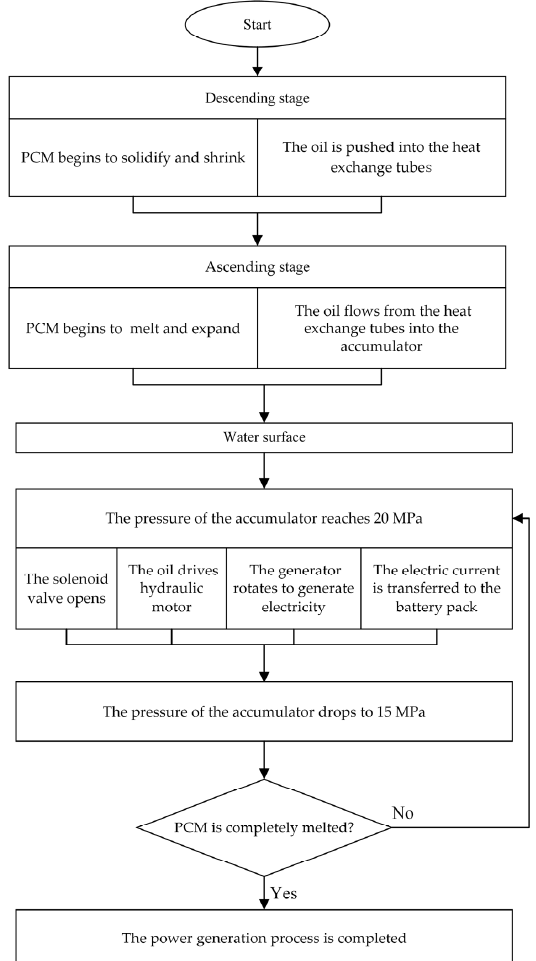
Figure 2. The working principle of the components.